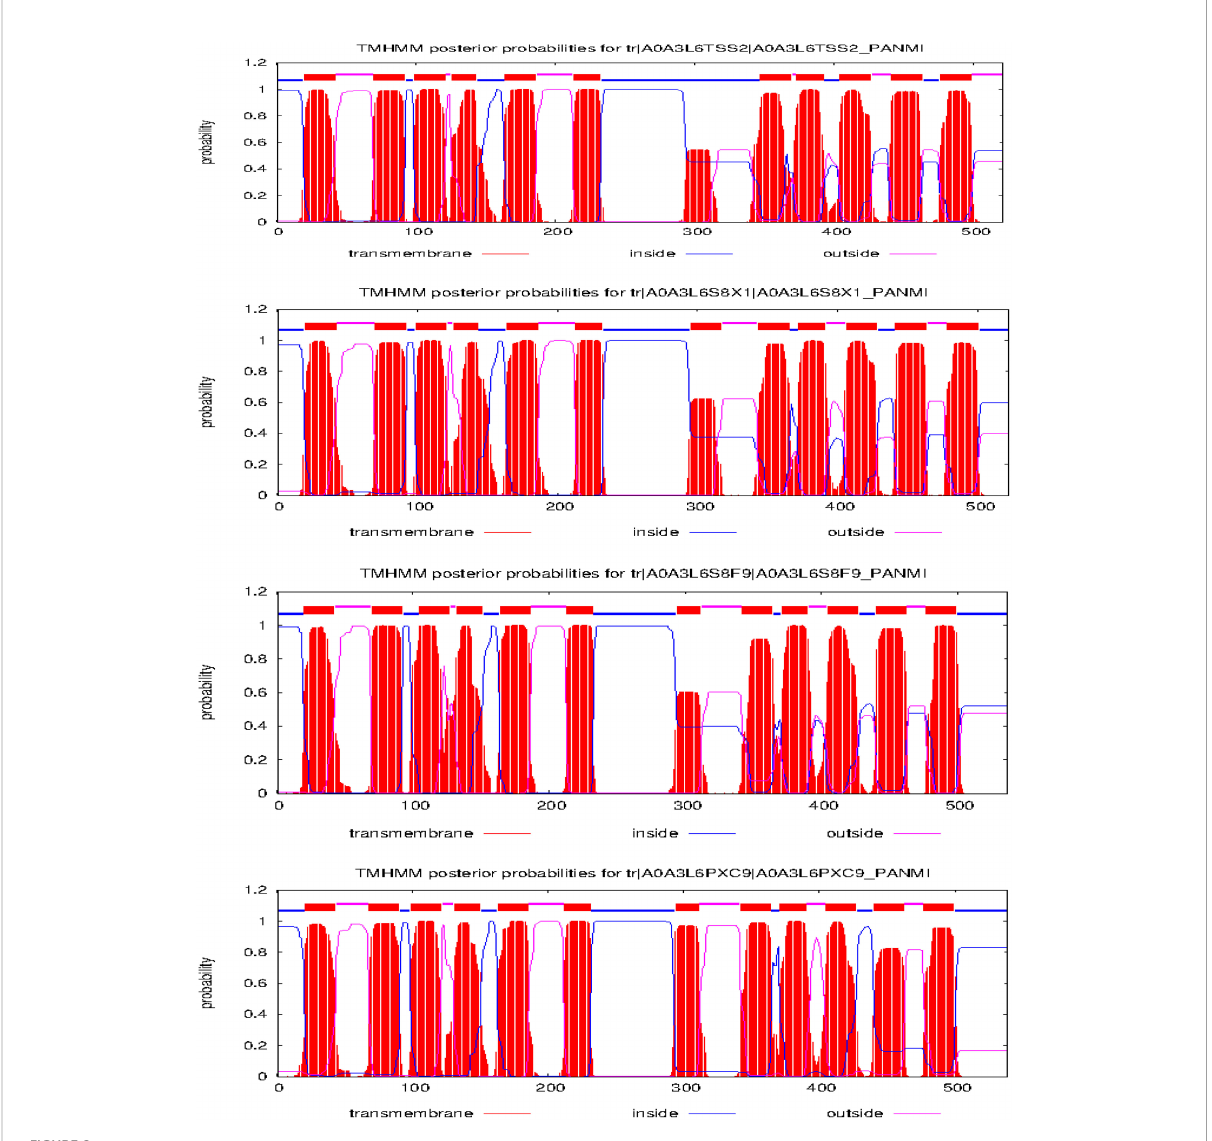
FIGURE 2 Trans-membrane helices prediction of selenite transporters in proso